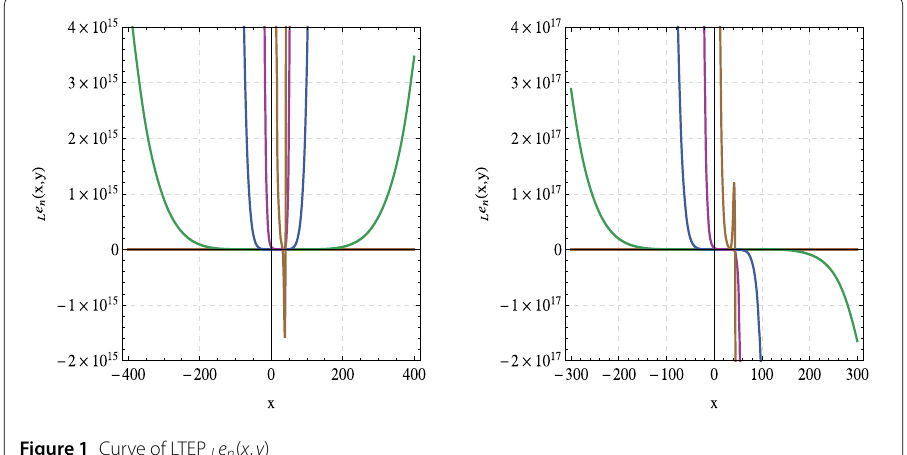
Figure 1 Curve of LTEP L e n ( x , y